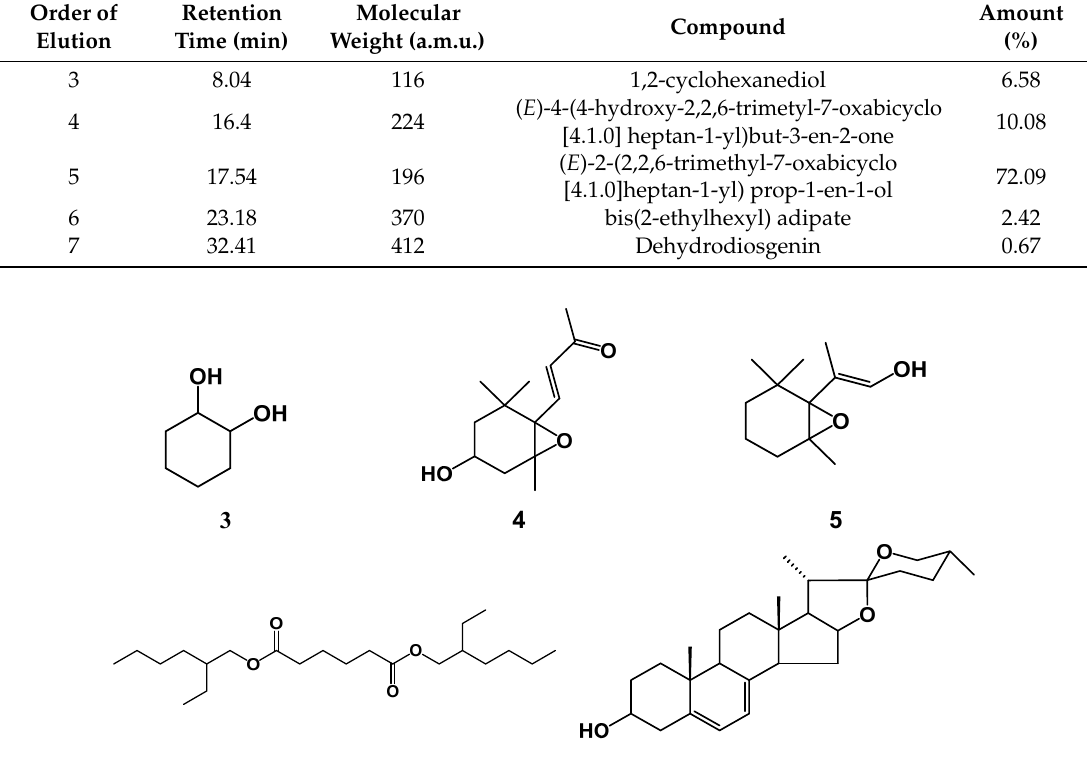
Table 3. Preliminary chemical composition by the GC-MS of F7AC fraction of Salix babylonica hydroalcoholic extract.